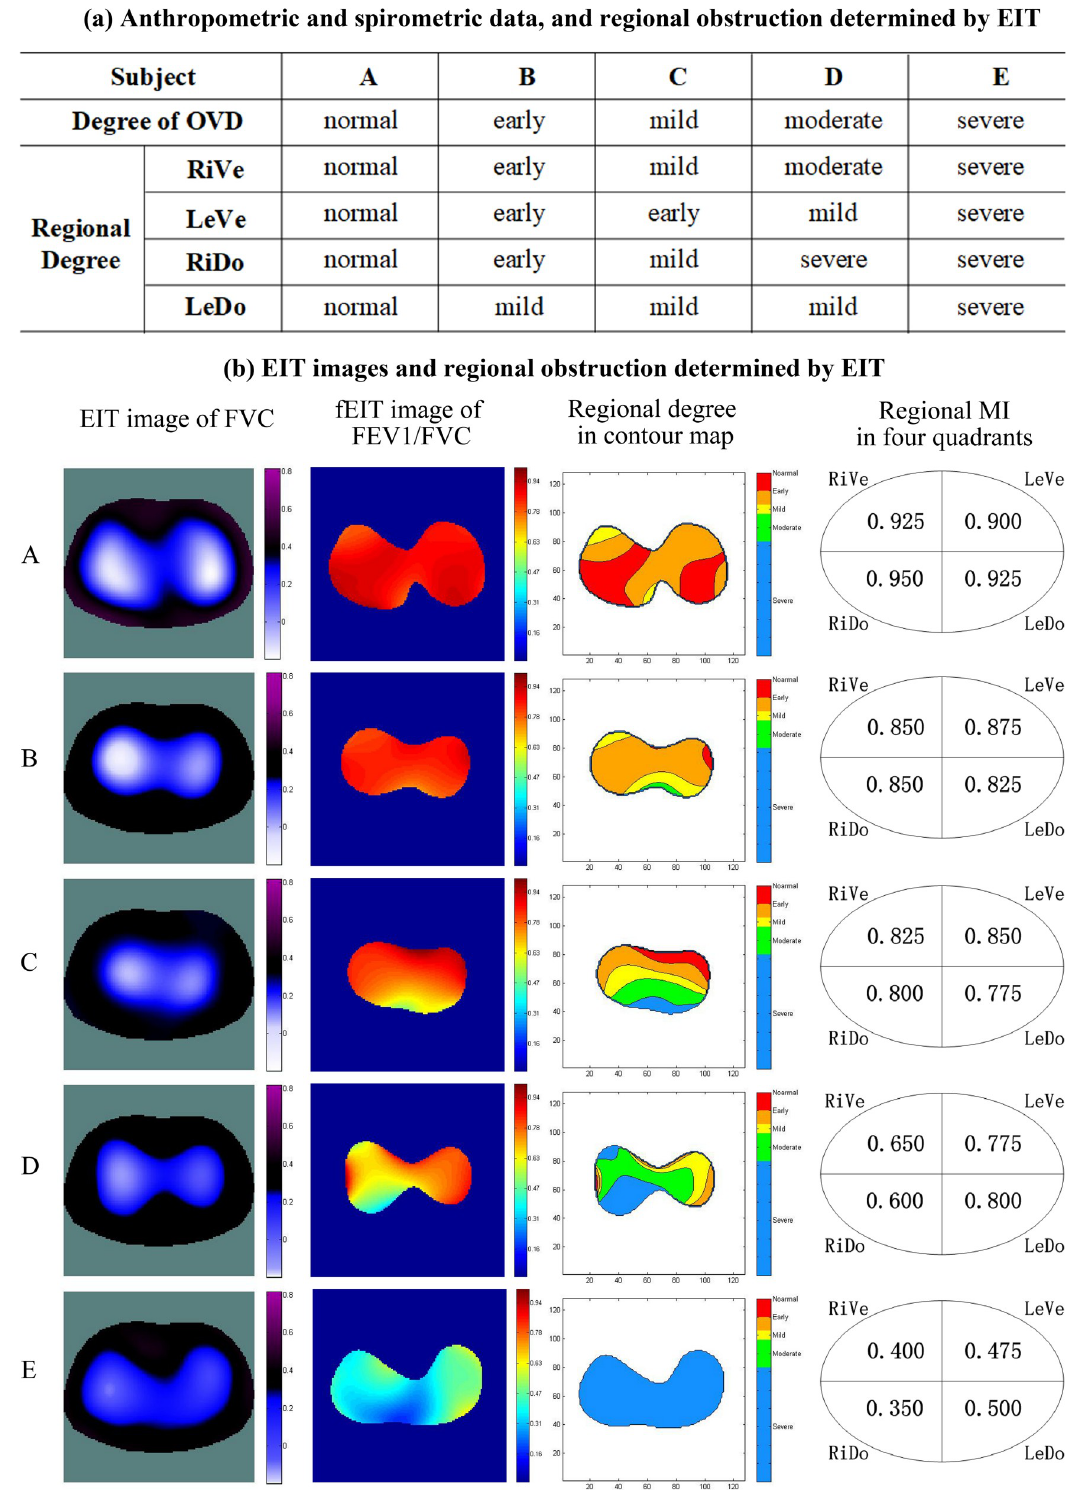
Fig 6. Anthropometric and spirometric data, EIT images and regional obstruction determined by EIT of 5 subjects. The image orientation is the following: ventral is at the bottom and the right side of the body is on the left of the image. FEV1, forced expiratory volume in 1 second; FVC, forced vital capacity. RiVe, right ventral; LeVe, left ventral; RiDo, right dorsal; LeDo, left dorsal.